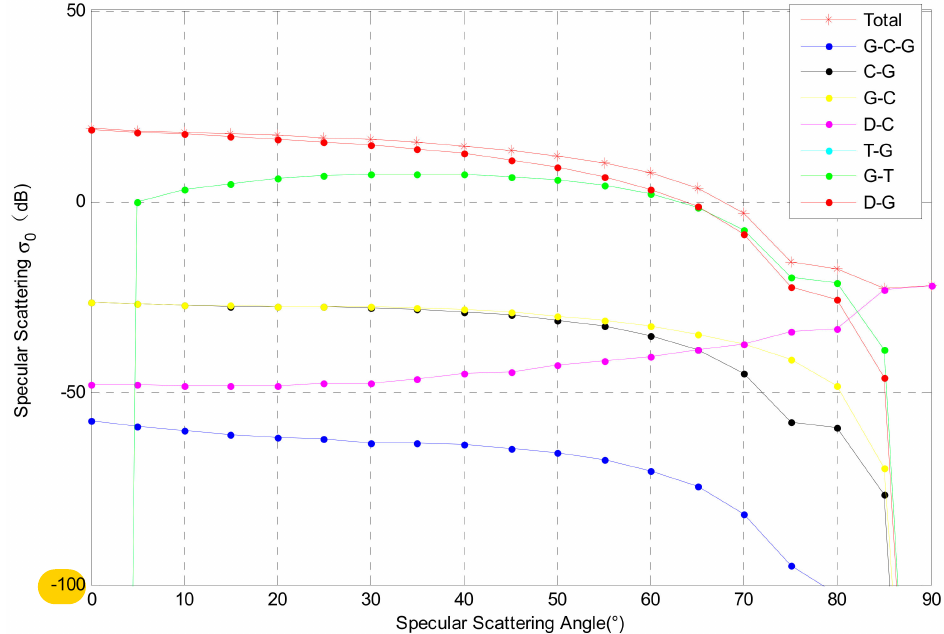
Figure 9. The relationship of different scattering mechanisms with the incident angle during specular